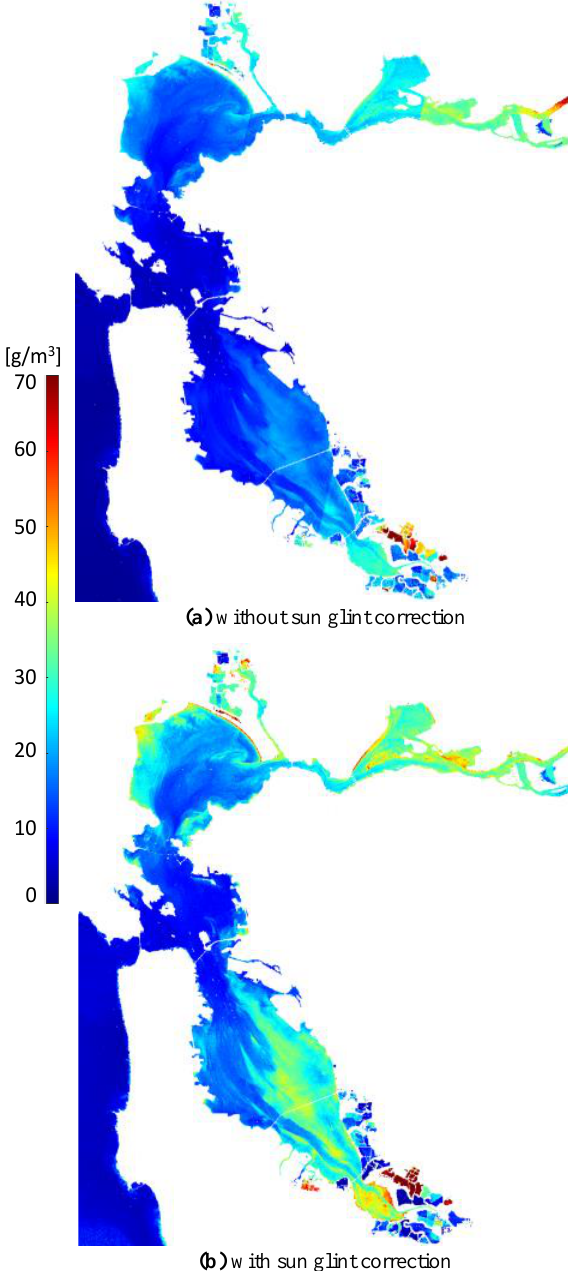
Figure 7 . TSM maps derived from OBRA without and with the sun glint